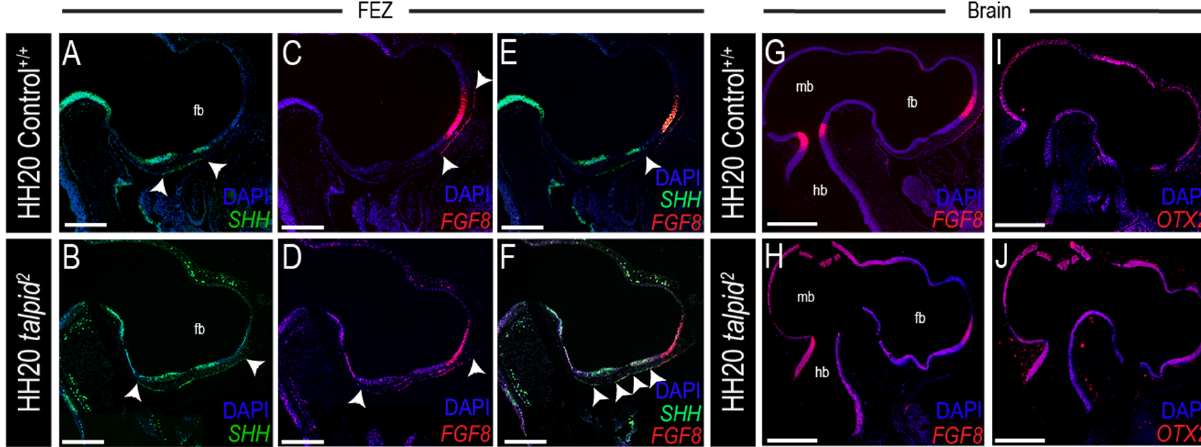
Figure 4. The frontonasal ectodermal zone (FEZ) is expanded and dispersed in ta 2 embryos. ( A – F ) RNAscope in situ hybridization for ( A , B ) SHH , ( C , D ) FGF8 or ( E , F ) both SHH and FGF8 in HH20 control +/+ and ta 2 craniofacial complexes. Arrowheads in ( A , B ) demarcate boundaries of SHH expression, arrowheads in ( C , D ) demarcate boundaries of FGF8 expression, and arrowheads in ( E , F ) demarcate the FEZ. ( G , H ) RNAscope in situ hybridization for FGF8 in HH20 control +/+ and ta 2 brains. ( I , J ) RNAscope in situ hybridization for OTX2 in HH20 control +/+ and ta 2 brains. fb: forebrain, hb: hindbrain, mb: midbrain. Scale bars: ( A – F ) 250 μ m, ( G – J ) 500 μ m.